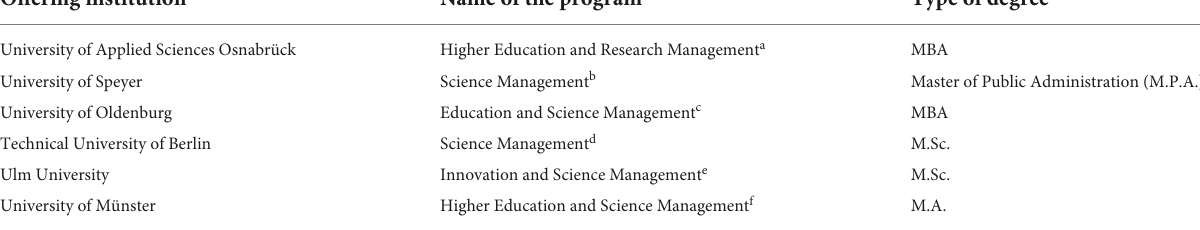
TABLE 1 Master’s programs in